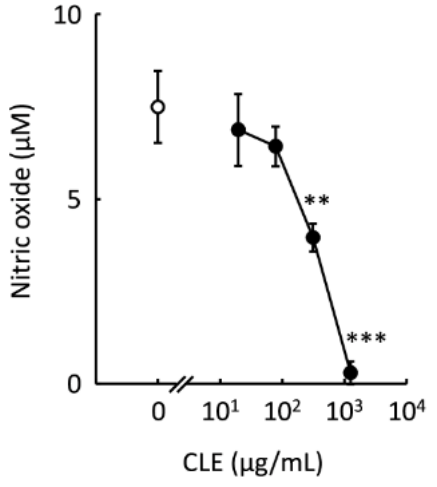
Figure 3. Effect of an aqueous extract from leaves of Citrus unshiu (CLE) on the production of nitric oxide by RAW 264.7 cells. RAW 264.7 cells were treated with various concentrations of CLE for 24 h, followed by LPS stimulation for 24 h. The culture medium was subsequently used for measuring nitric oxide concentration by Griess assay. An open circle indicates the LPS-stimulated cells treated with water instead of CLE (control). The concentration of nitric oxide produced from the cells not stimulated with LPS was below the limit of quantitation. Data are represented as mean ± SEM of three independent experiments. ** p < 0.01 or *** p < 0.001 against control by Dunnett’s test.